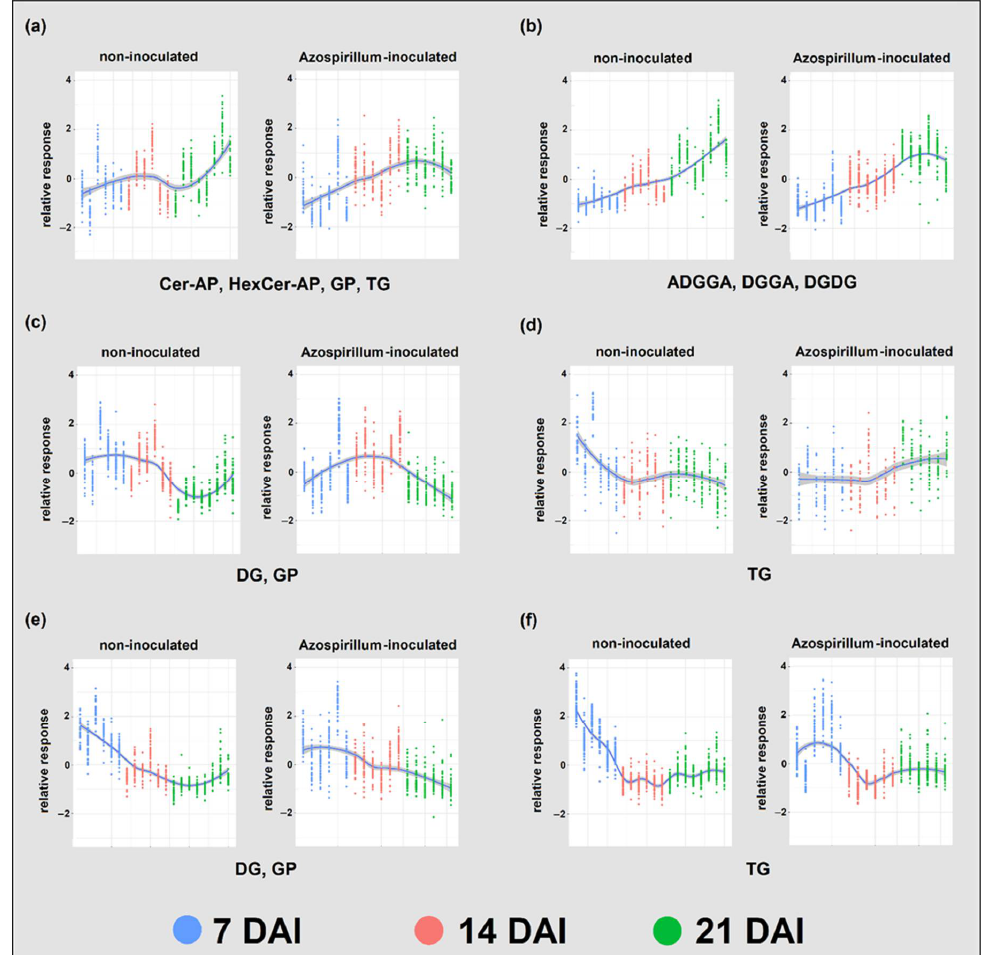
Figure 4. Profile of lipid species identified in Azospirillum-inoculated and non-inoculated samples harvested at 7, 14, and 21 DAI using K-means clustering. Clusters formed in the two treatments were paired based on their lipid species composition ( a – f ). At each time point, biological replicates are displayed as lines of dots, where each dot represents a lipid species. The main lipid classes of each cluster couple are also displayed. Shade of the fitting line represents the standard deviation